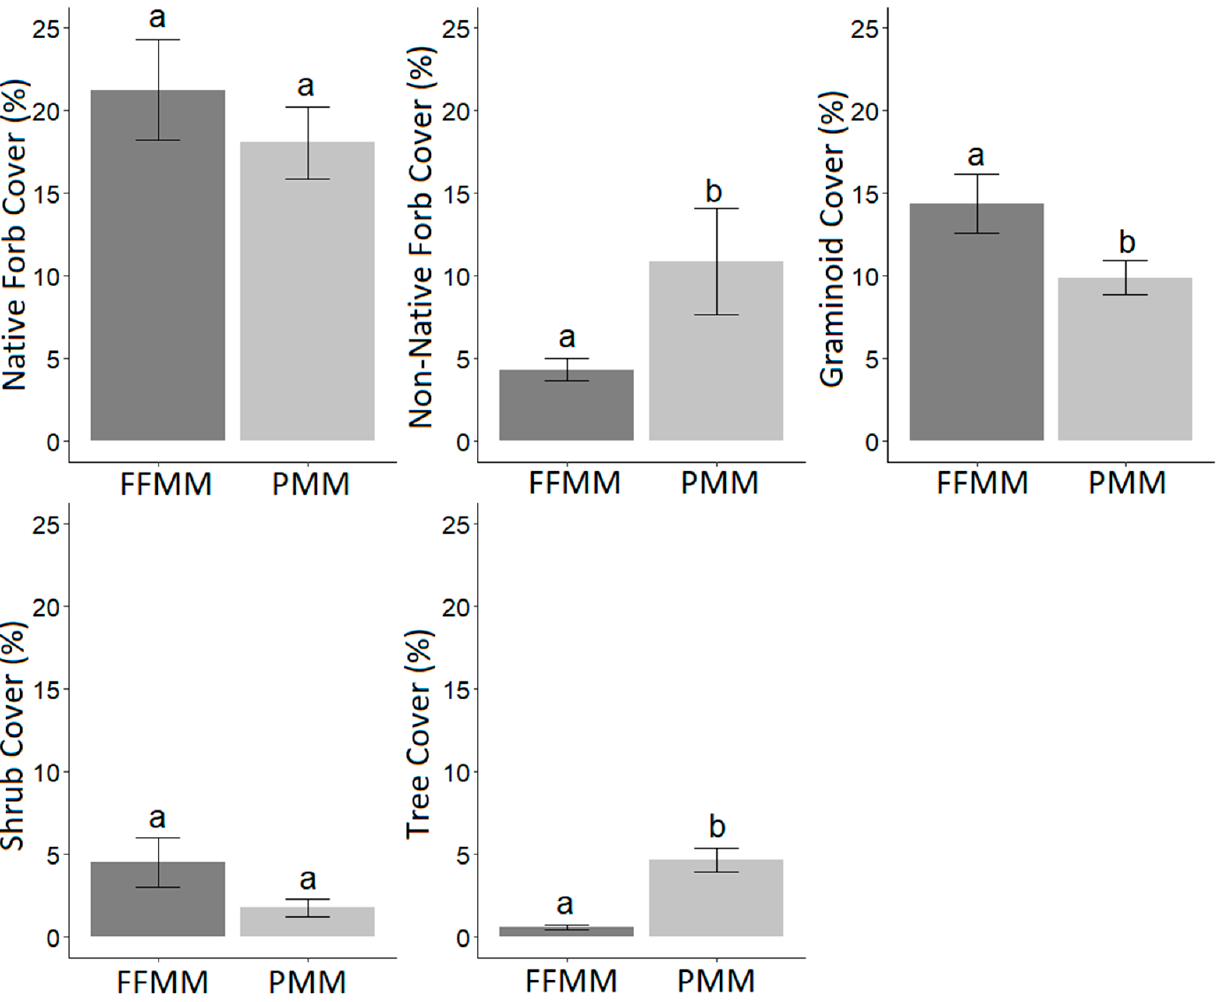
Figure 1. Average percent cover by functional group comparison of forest floor-mineral mix (FFMM) and peat-mineral mix (PMM) soil types with standard error bars and significant letters based on permutational analysis of variance (permANOVA) (FFMM n = 20; PMM n = 20).